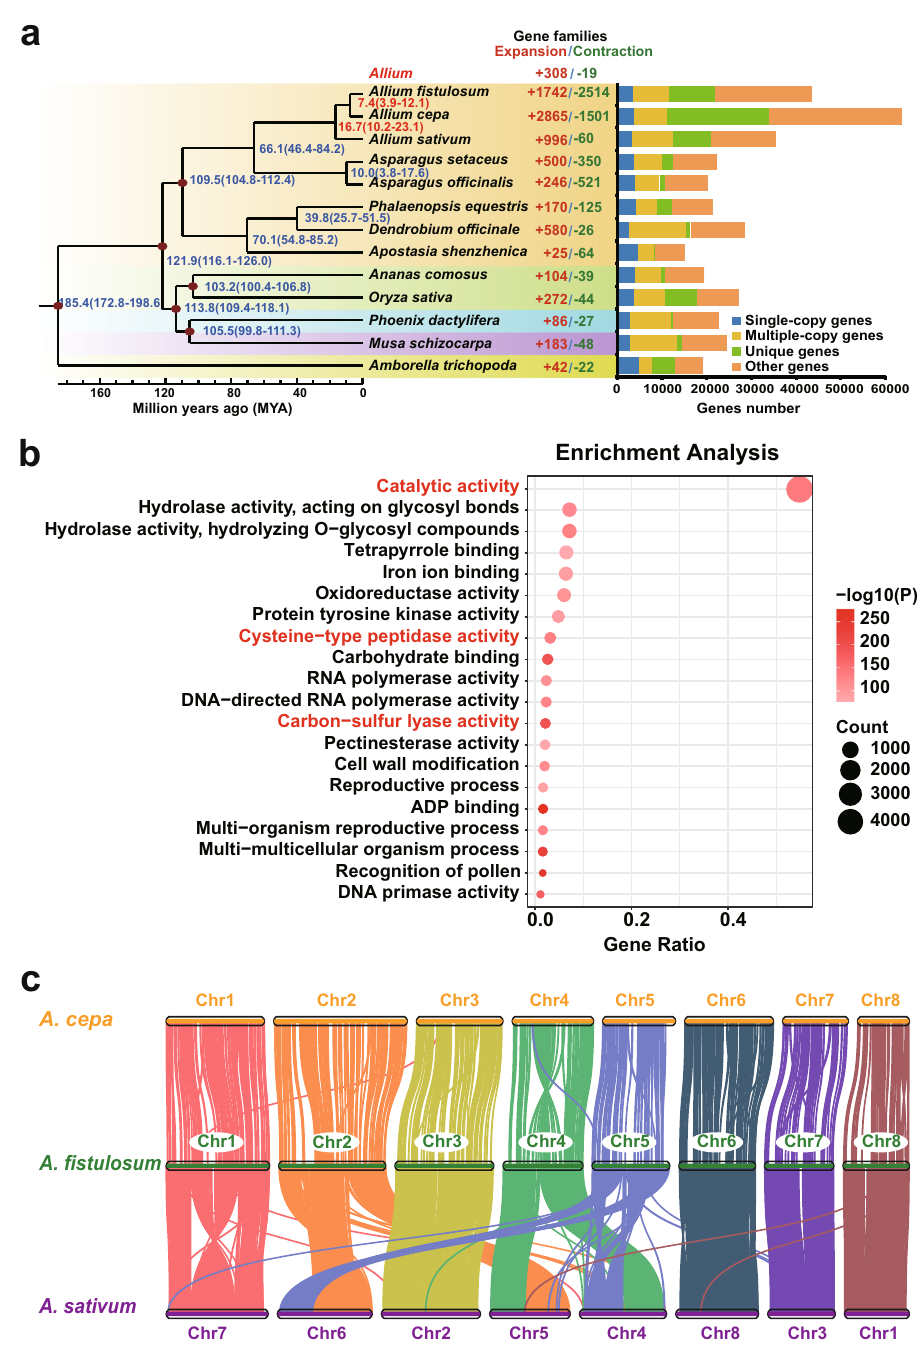
Fig. 2 | Genome evolution and relatedness of Allium crops. a The phylogenetic tree of 13 plant species and the evolution of the gene families. Numerical values besides eachnode show the estimateddivergencetimeofeachnode. Thered dots on the nods indicate the existence of fossil evidence that supported the estimated time. The numbers in the middle panel indicated the expanded and contracted gene families. The right panel displays the gene number of single-copy, multiple-